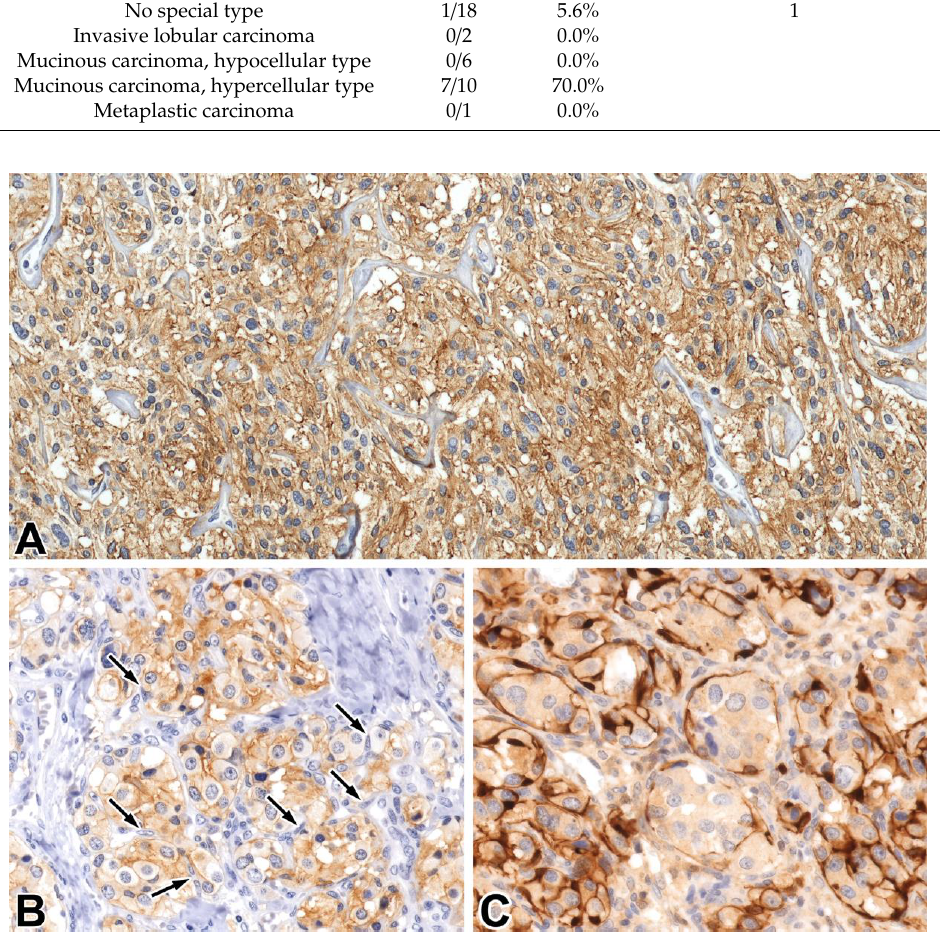
Figure 6. STX1 (A, B) and S100 (C) immunoreactivity in pheochromocytomas, for which the arrows indicate sustentacular cells (B) . The latter cells were visualized with an S100 IHC reaction. (A) : 20x, indicate sustentacular cells ( B ) The latter cells were visualized with an S100 IHC reaction. ( A ): 20x, (B, C) : 40x. ( B , C ):